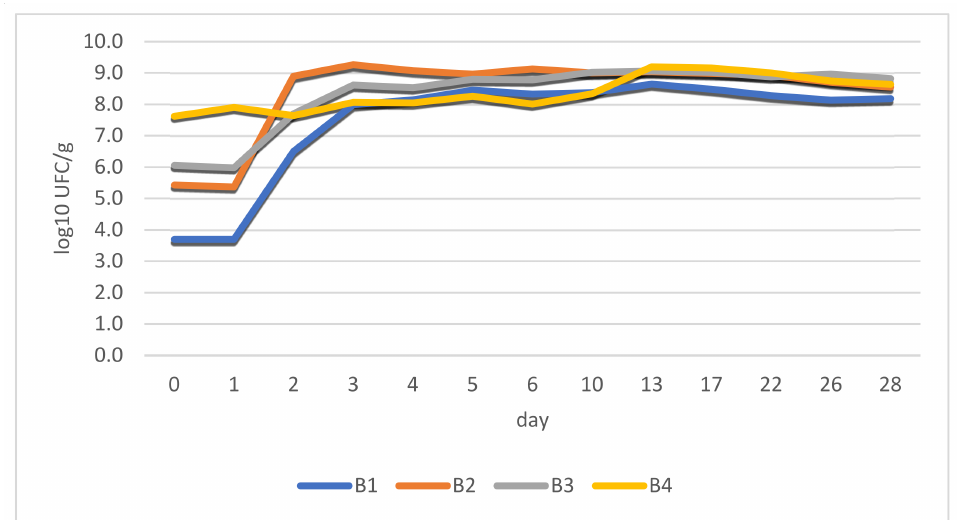
Figure 4. LAB growth during the 28-day fermentation period in the case of four batches of fermented salami with different sources of fermenting bacteria.